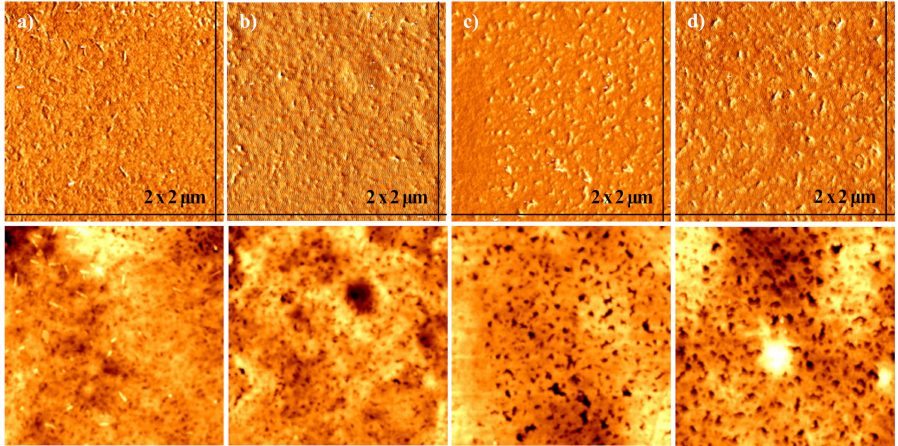
Figure 8. AFM images of ( a ) 0 wt%, ( b ) 3 wt%, ( c ) 5 wt%, and ( d ) 9 wt% DMSO paste